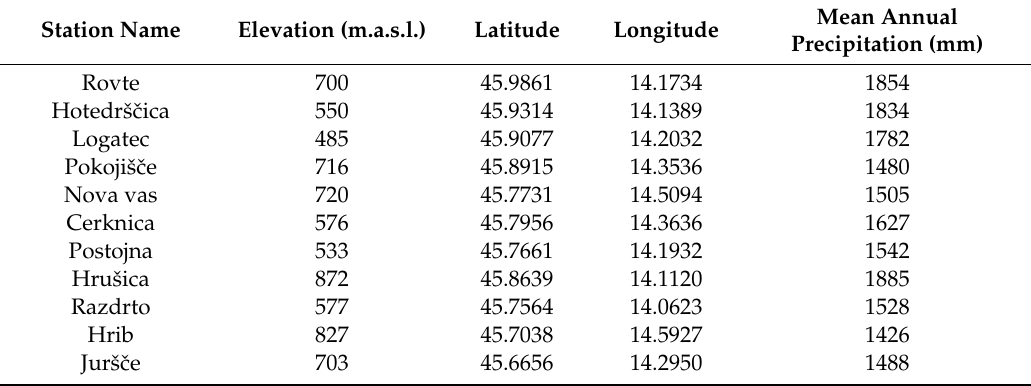
Table 2. Basic characteristics of rainfall stations used in the process of model